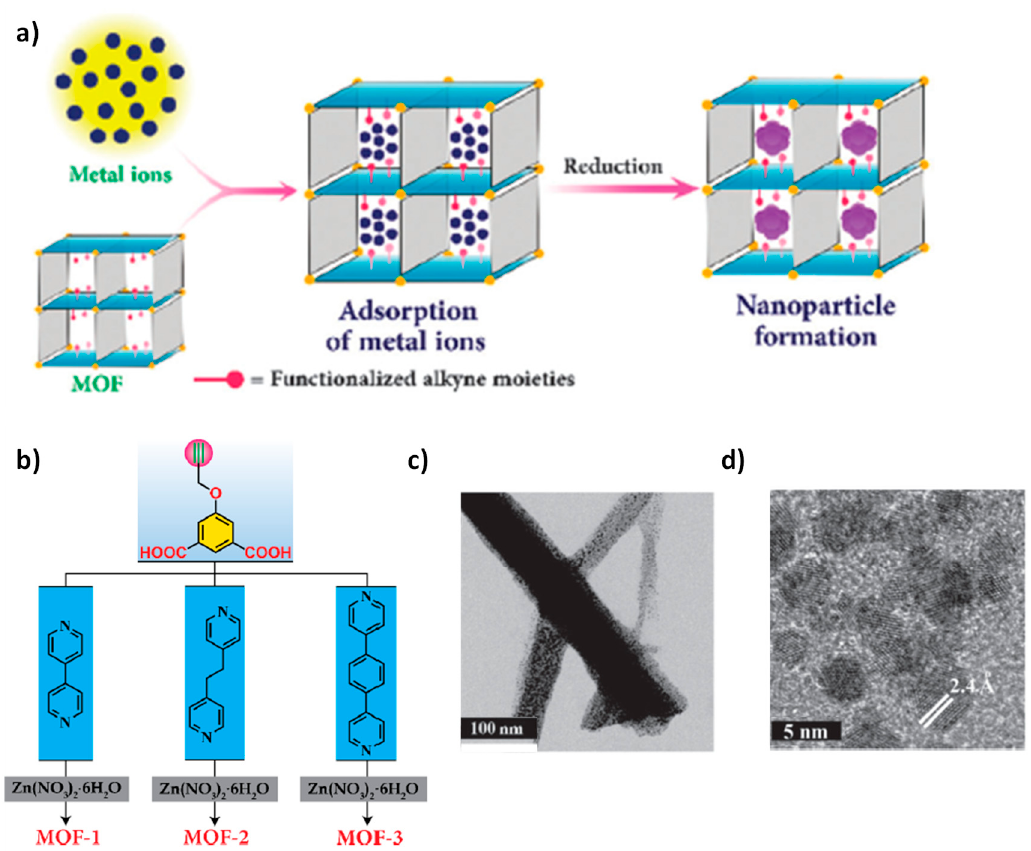
Figure 5. ( a ) Schematic illustration of MNPs synthesis on ethynyl-based MOFs. ( b ) Chemical structure of the ligands employed for the preparation of the MOFs, ( c ) STEM bright field image of the Au@MOF-3. ( d ) HRTEM image showing lattice spacing (d = 2.4 Å) corresponding to (111) plane of fcc Au. Reproduced with permission from [56].